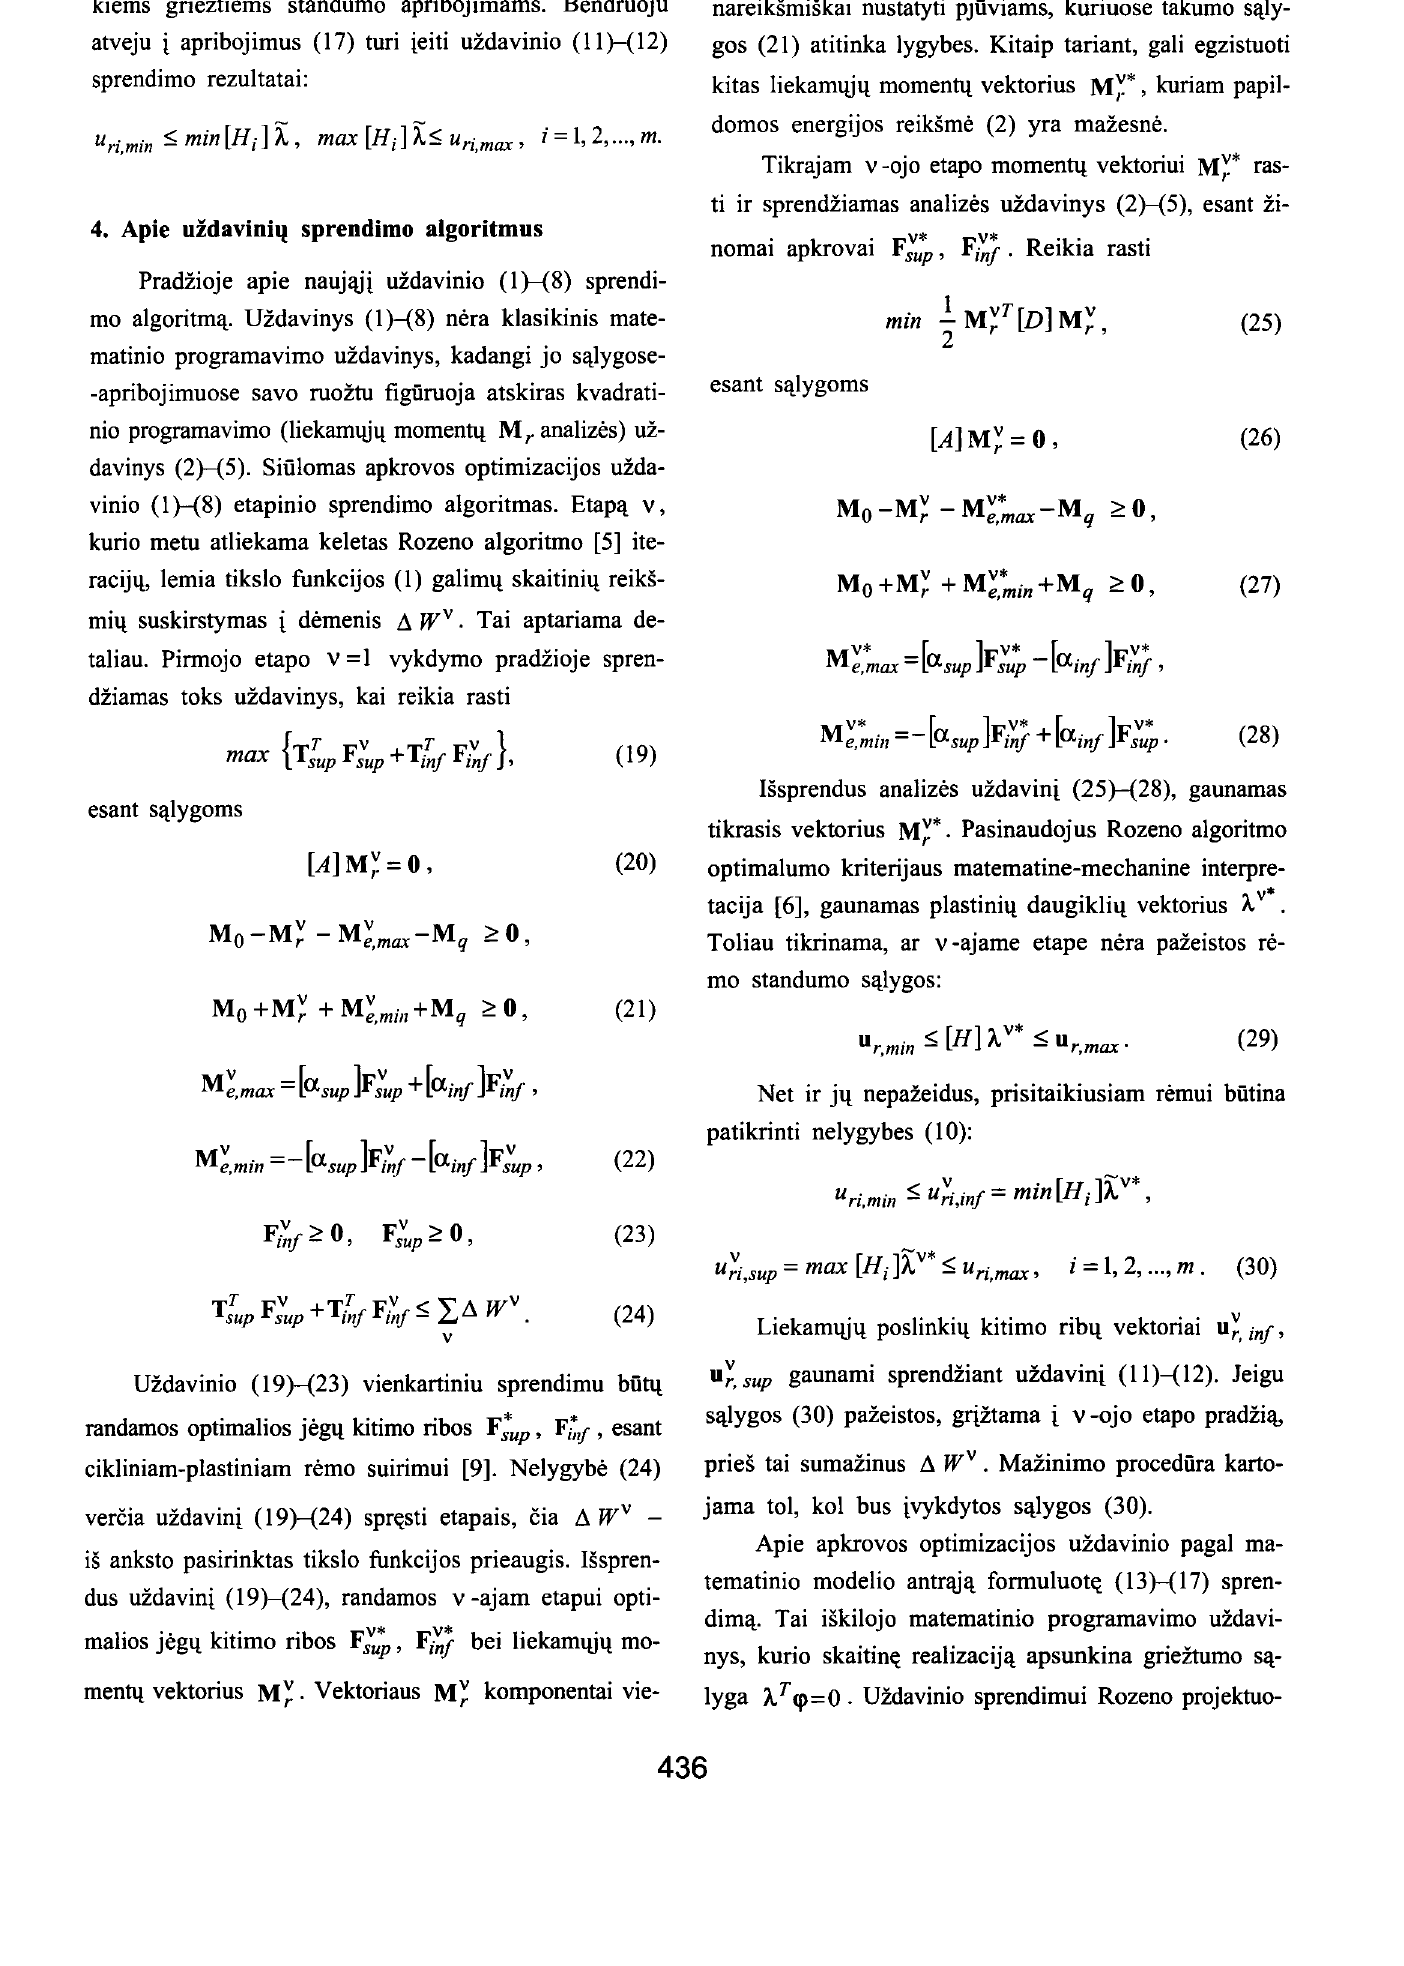
Pradzioje apie naujliji uzdavinio (1}--{8) sprendi mo algoritml!. Uzdavinys (1)-(8) nera klasikinis mate matinio programavimo uzdavinys, kadangi jo Sl!lygose -apribojimuose savo ruoztu figiiruoja atskiras kvadrati